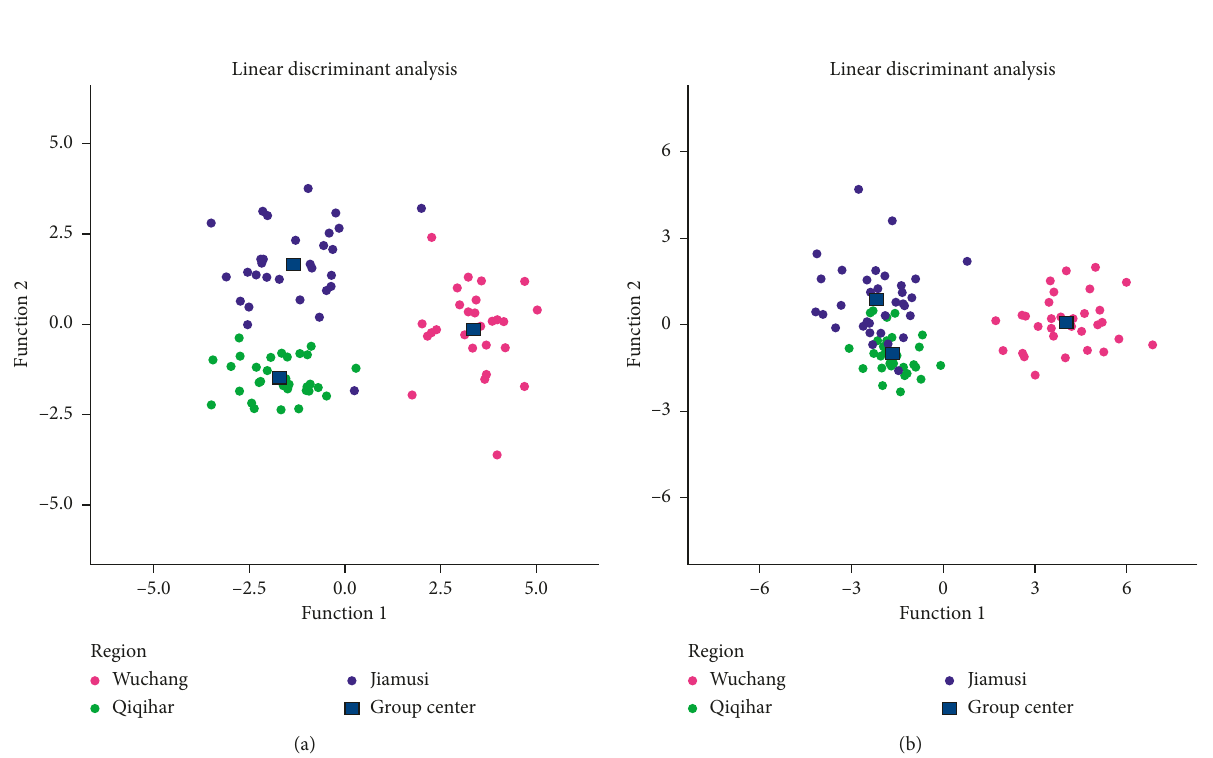
Figure 1: Scatter plot of discriminant scores from functions 1-2 of (a) 2013 and (b) 2014